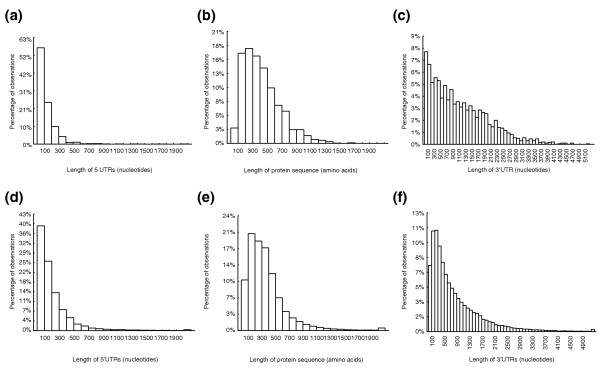
Comparison of the length distributions of bursal cDNAs and public database sequences. The length distributions of 5' UTRs from (a) bursal cDNAs and (d) 5' UTR sequences present in UtrDB. The length distribution of annotated ORFs from (b) bursal cDNAs and (e) UniProt database sequences. The length distributions of 3' UTRs from (c) bursal cDNAs and (f) 3' UTR sequences present in UtrDB. Lengths of UTR sequences are given in nucleotides; lengths of ORFs in amino acids.